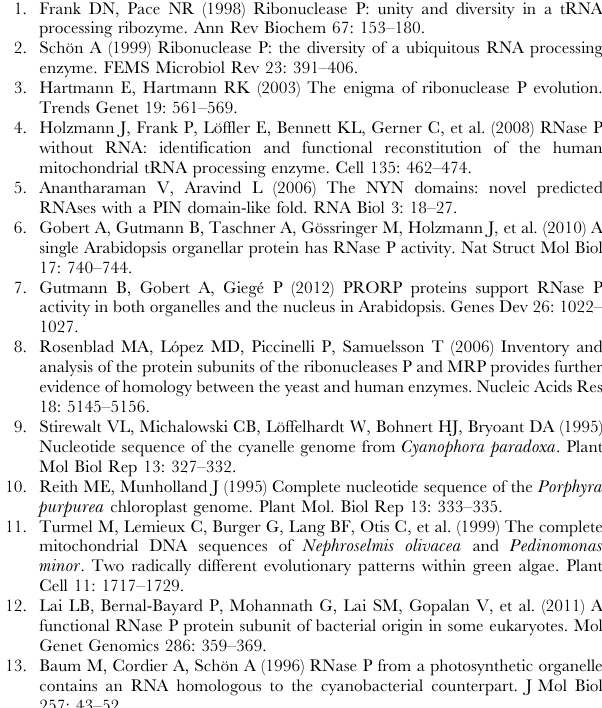
Figure S7 Northern blot analysis of chloroplast tRNAs.